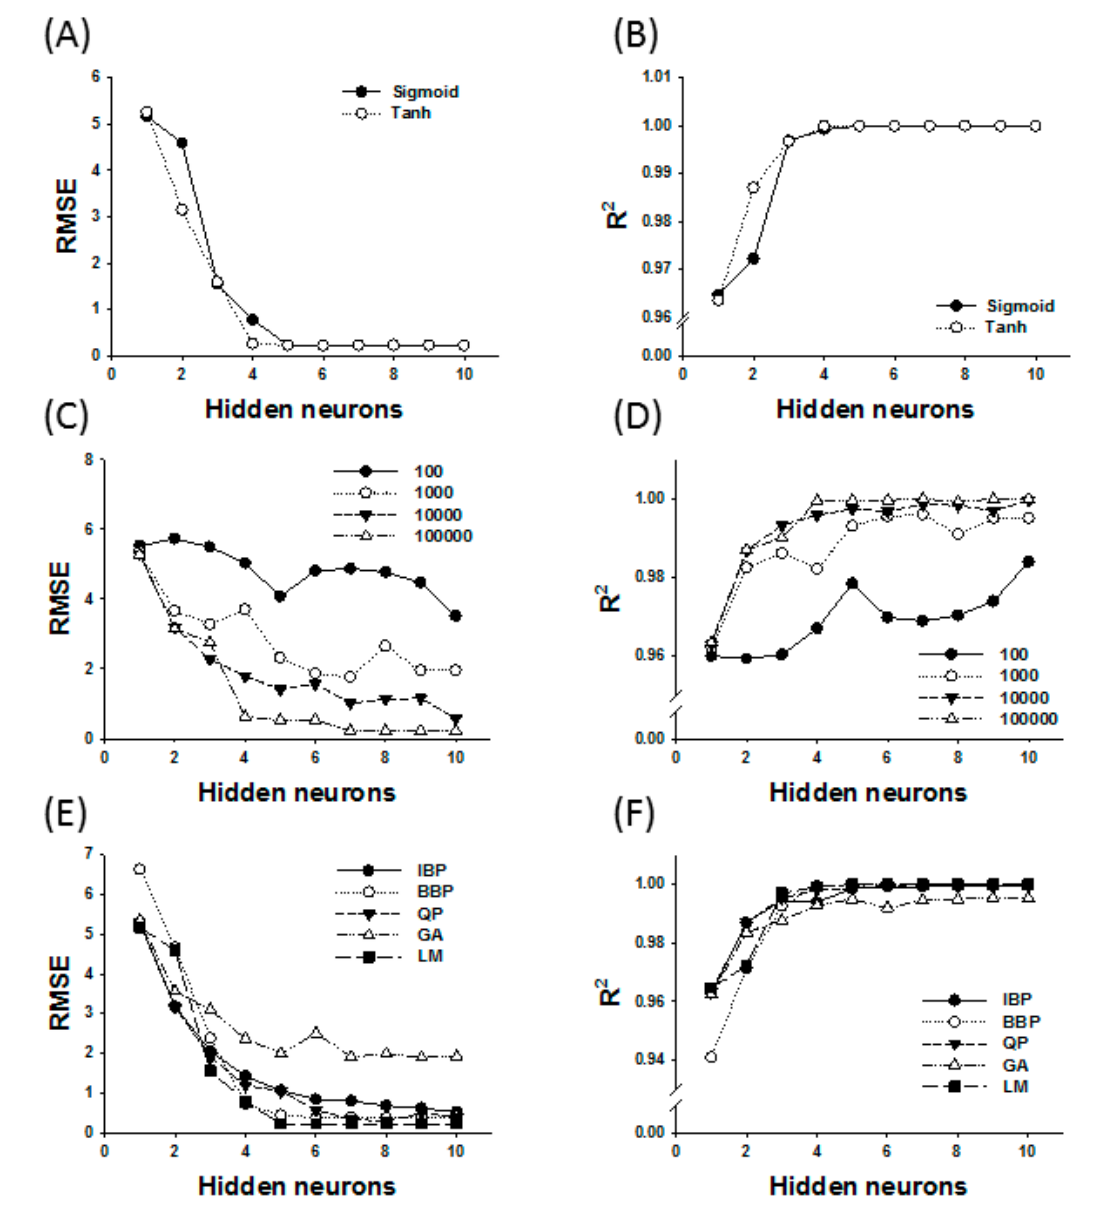
Figure 4. Effects of the transfer function, iteration, learning algorithm and number of hidden neurons on the performance of ANN. ( A , B ) Effects of sigmoid or hyperbolic tangent (Tanh) transfer functions employed in training sets on the performance of ANN; ( C , D ) Effect of iterations (100–100,000) on the performance of ANN; ( E , F ) Effects of learning algorithm and number of hidden neurons on the performance of ANN. IBP, increment back propagation; BBP, batch backpropagation; QP, quick propagation; LM, Levenberg-Marquardt algorithm; GA, genetic algorithm. ANN performance was evaluated by the coefficient of determination ( R 2 ) and the root mean square error ( RMSE ).